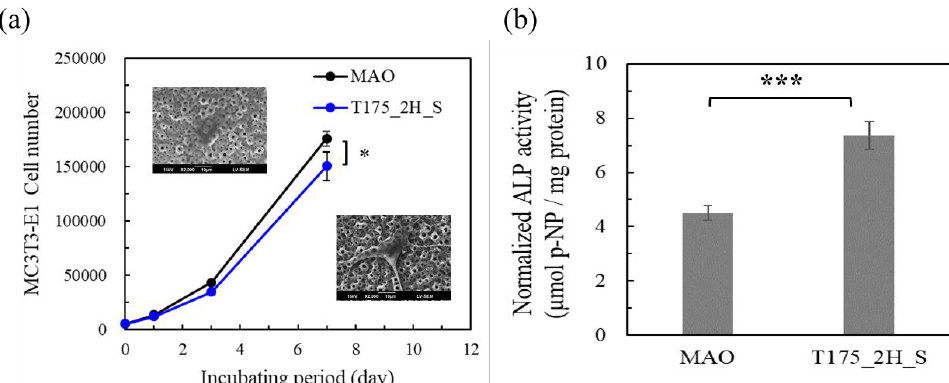
Figure 8. The MC3T3-E1 cells activity test in vitro on the MAO coatings and hierarchical HA coating fabricated using a hydrothermal treatment at 175 °C for 2 hours (sample T175_2H_S). ( a ) The MC3T3-E1 cell number, and ( b ) normalized alkaline phosphatase (ALP) activity of the MC3T3-E1 cells.